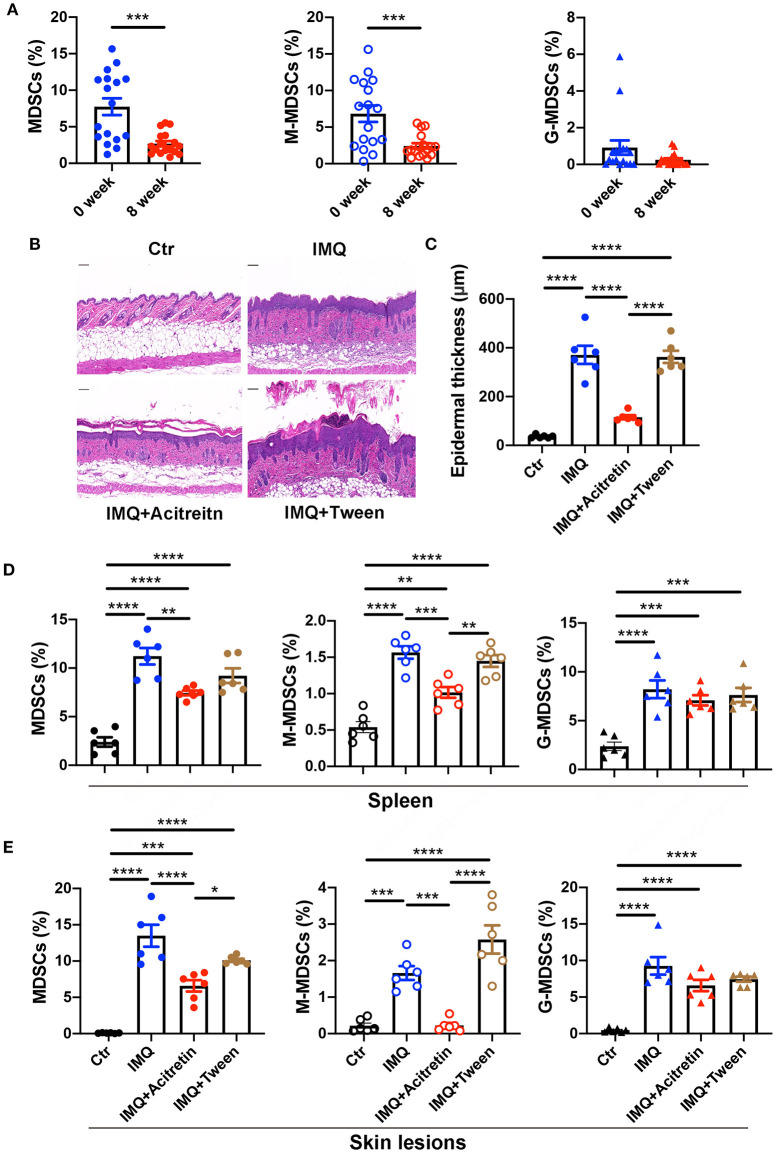
Acitretin deceased the number of MDSCs and M-MDSC in vivo. (A) The percentages of MDSCs (left panel), M-MDSCs (middle panel), and G-MDSCs (right panel) in PBMCs of psoriasis patients before and after the treatment of acitretin for 8 weeks (n = 17). IMQ-induced psoriasis-like model mice treated with oral acitretin or tween (solvent) once per day for 6 days. (B) The H&E staining of the back skin derived from Control (Ctr) and IMQ-induced model mice treated with acitretin or tween (solvent) (n = 6). Scale bars: 100 μm. (C) The epidermal thickness of mice in B (n = 6). (D,E) The statistical data of Gr-1+CD11b+ MDSCs (left panel), CD11b+Ly6G−Ly6C+ M-MDSCs (middle panel), and CD11b+Ly6G+Ly6C− G-MDSCs (right panel) in the spleen (D) and skin lesions (E) of IMQ-induced psoriasis-like model mice treated with oral acitretin or tween (solvent) (n = 6). All results represent at least 3 independent experiments. Data represent the mean ± SEM. *p < 0.05, **p < 0.01, ***p < 0.001, ****p < 0.0001.